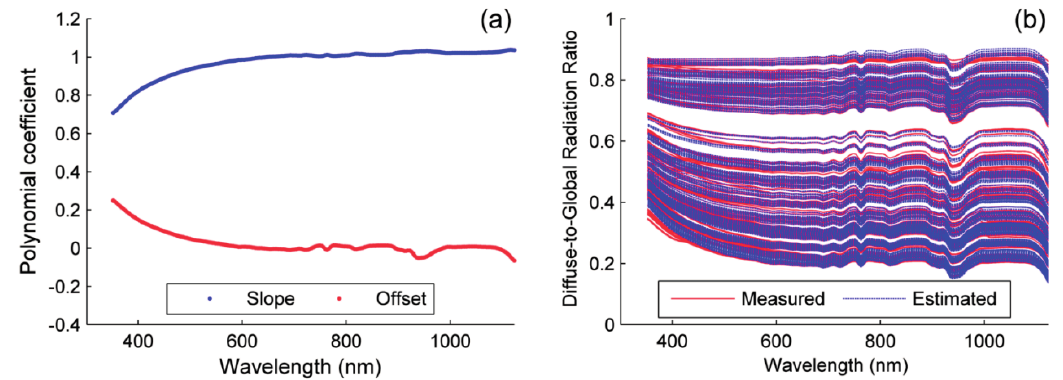
Figure 6. ( a ) DGr linear model coefficients. ( b ) Measured and estimated spectral DGr